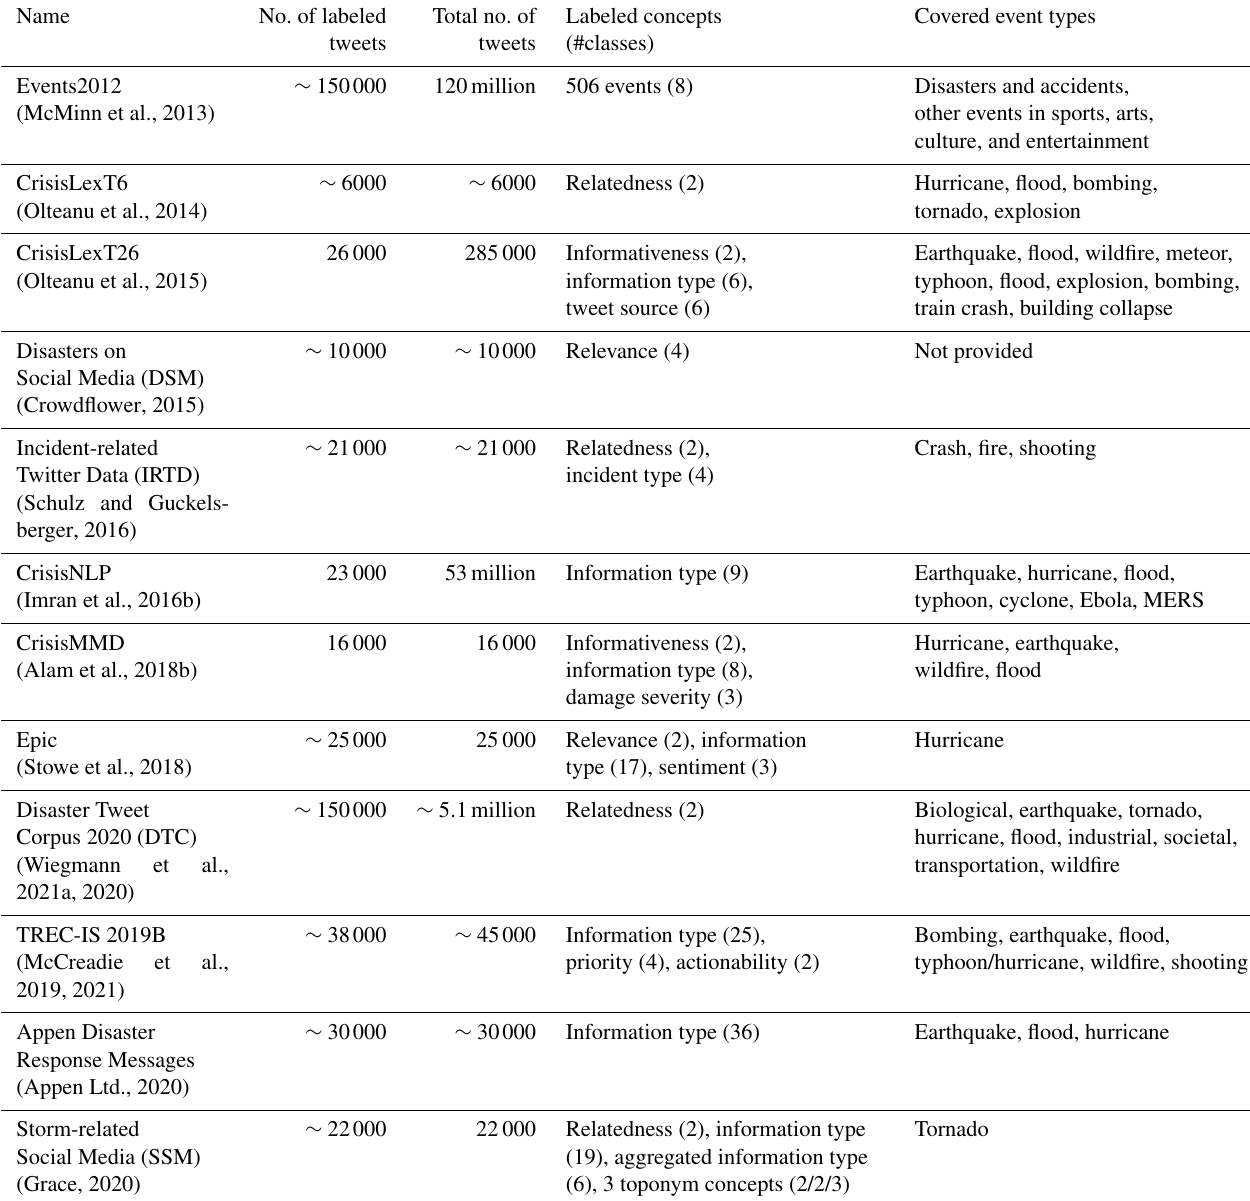
Table 2. Overview of crisis-related Twitter data